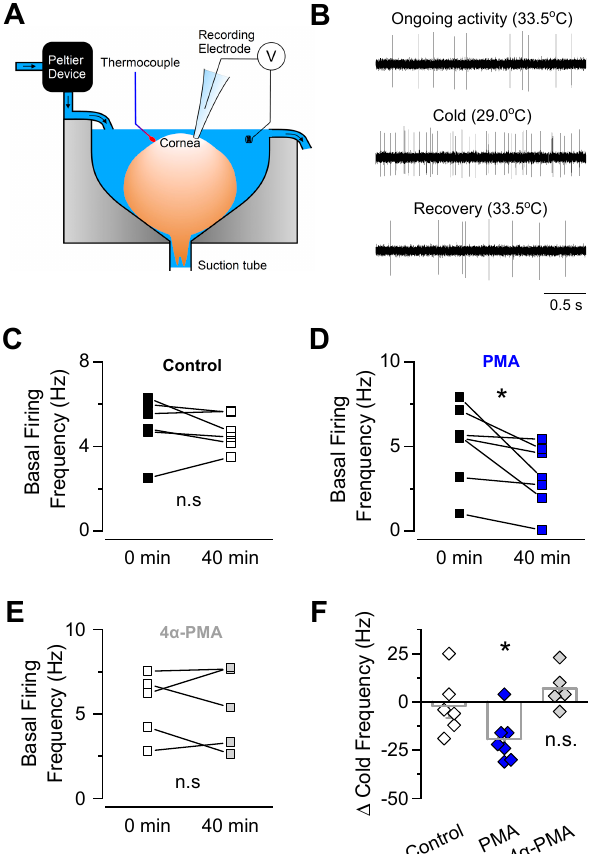
Figure 6. PMA incubation of corneal TRPM8( + ) nerve endings reduced their ongoing activity and cold-evoked responses. ( A ) Experimental arrangement of the ex vivo preparation used to record nerve terminal impulse (NTI) activity from corneal cold-sensitive nerve endings in isolated mouse eyes (modified from [5]). ( B ) Examples of 2.5 s of NTI activity recording from a TRPM8( + ) cold-sensitive nerve ending in basal conditions, in response to cold, and after rewarming. ( C – E ) Ongoing NTI activity before and after application of control solution ( C ), 2 µ M PMA ( D ) or 2 µ M 4 α -PMA ( E ) in cold-sensitive nerve endings. Statistical significance was assessed by paired t test; * p < 0.05; n.s., not significant. ( F ) Frequency change of NTI activity evoked by consecutive cold pulses from 34 to 20 ◦ C, at time 0 and 40 min, after application of control solution, PMA or 4 α -PMA. Data is expressed as the di ff erence between the peak of cold-evoked response at 40 min minus the peak of the response obtained during the first cold pulse in each single nerve ending. Statistical significance was assessed by an ANOVA test in combination with a Dunnett’s post hoc test; * p < 0.05; control, n = 6; PMA, n = 7; 4 α -PMA, n = 5; n.s. not significant.